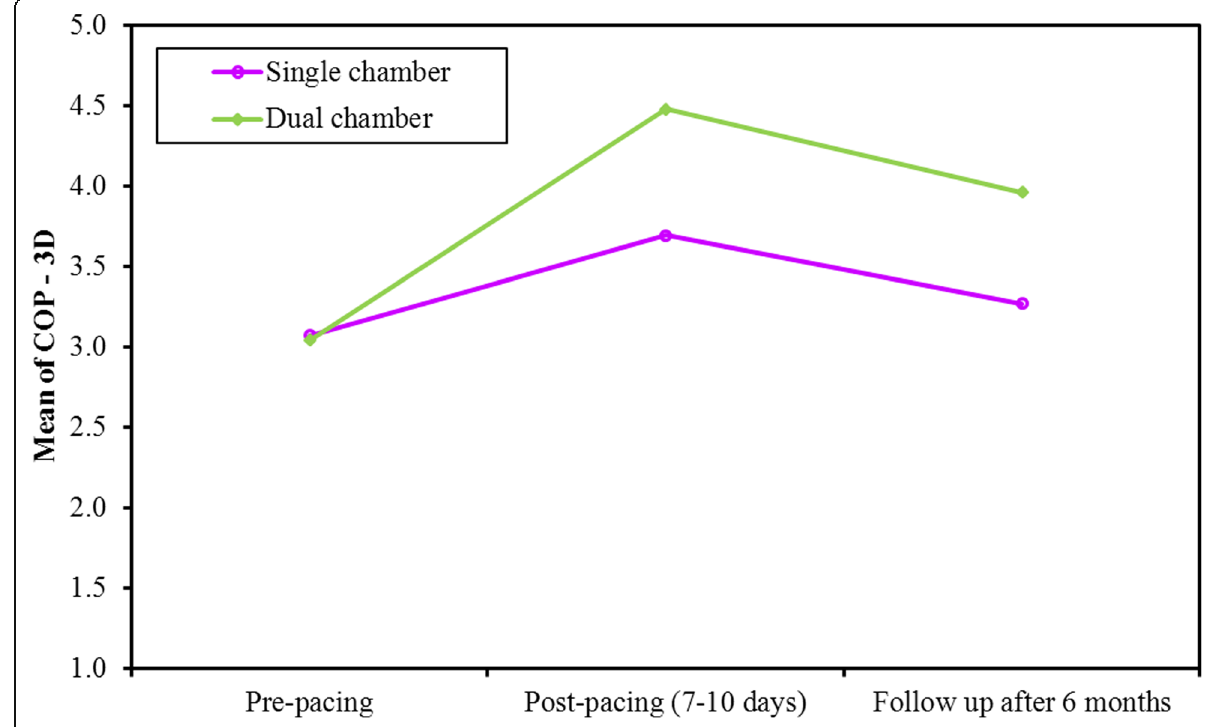
Fig. 2 Comparison between the different periods according to 3D COP in each group